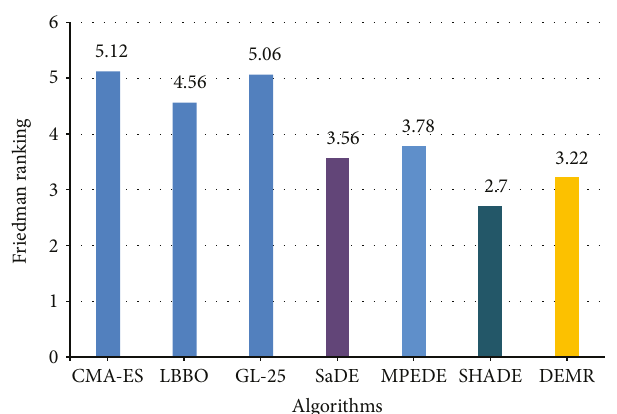
Figure 5: The convergence graphs on di ff erent types of CEC2005 benchmark functions.